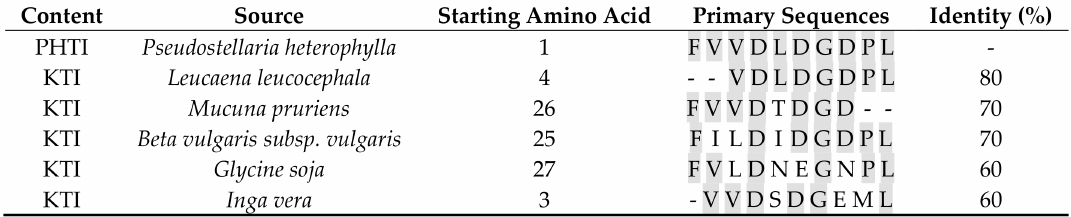
Table 2. Analysis of the N-terminal sequence of Kunitz-type inhibitor from P. heterophylla roots. Content